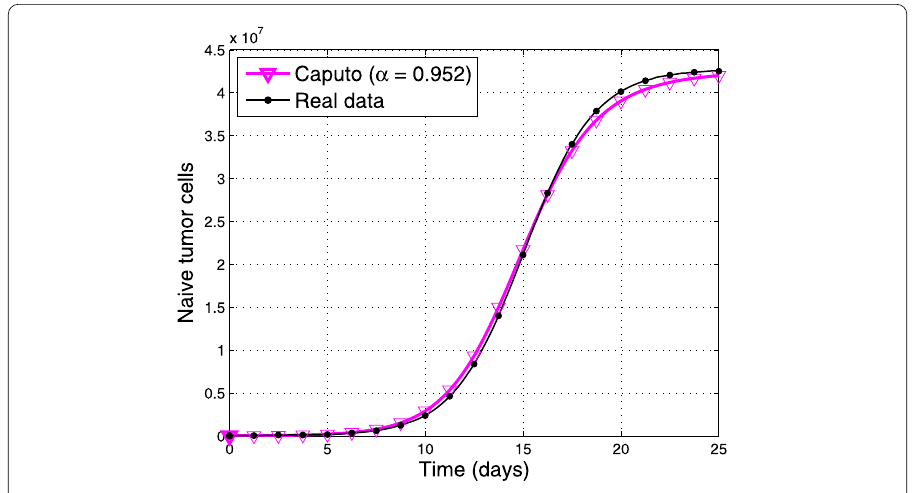
Figure 1 The growth of naive tumour cell population derived by the Caputo fractional model with α = 0.952 [29] versus the real data of tumour growth used in [49]